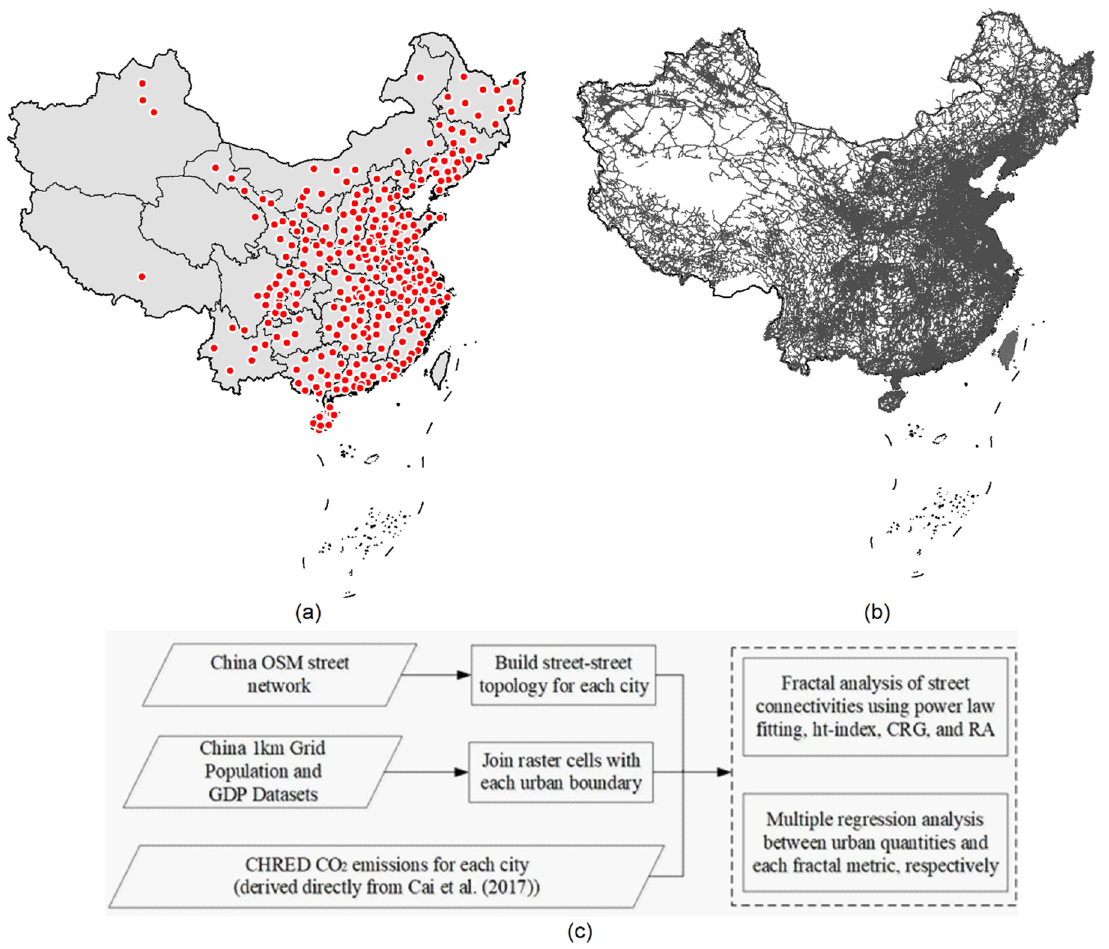
Figure 1. (Color online) Spatial distribution of ( a ) selected 298 cities, ( b ) national street network, and ( c ) the methodological framework in this study.